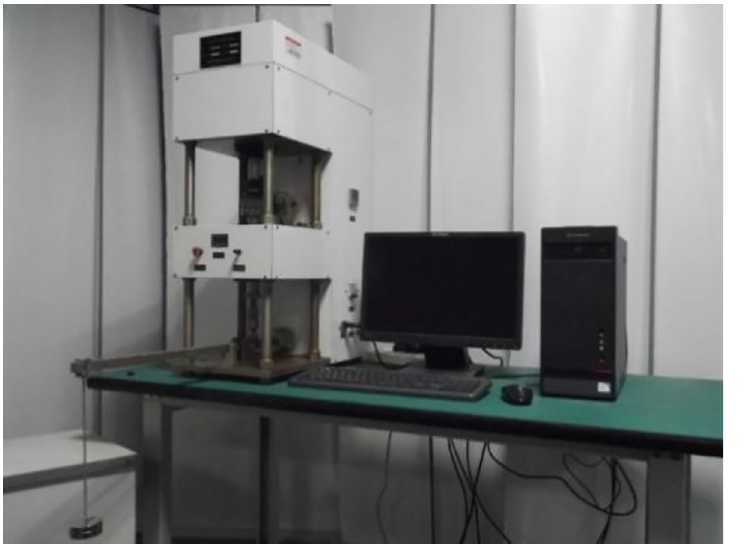
Fig 3. Universal friction and wear tester